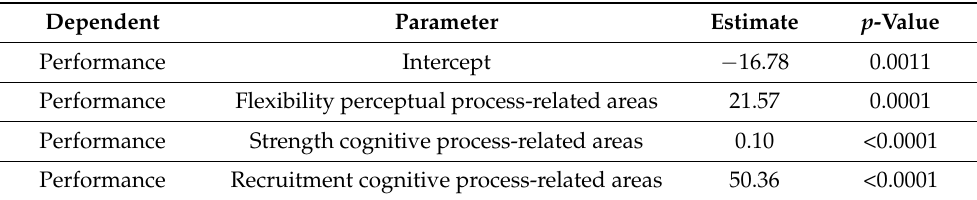
Table 3. Result of the multivariate linear analysis, representing EEG features associated with RAS surgeon performance.